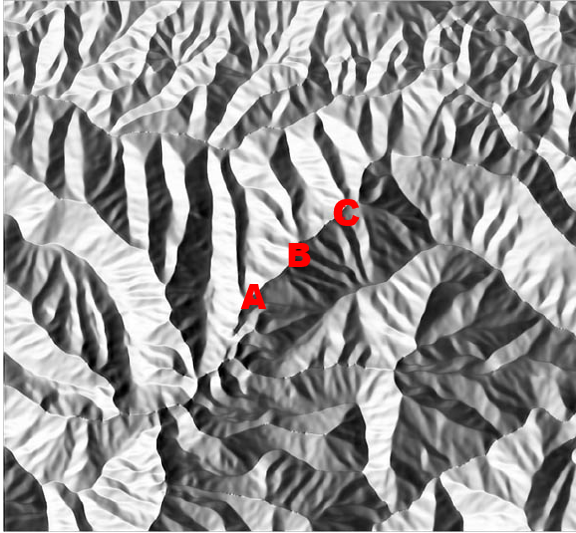
Figure 2. A shaded relief map (SRM) showing a ridge that is illuminated at 270 degrees where the relief inversion (also known as terrain reversal effect) might be present for some viewers. Assuming you see the ABC as a ridge, if you rotate this image, the ridge should turn to a valley (or vice versa). This figure is adapted from Biland and Çöltekin (2016).